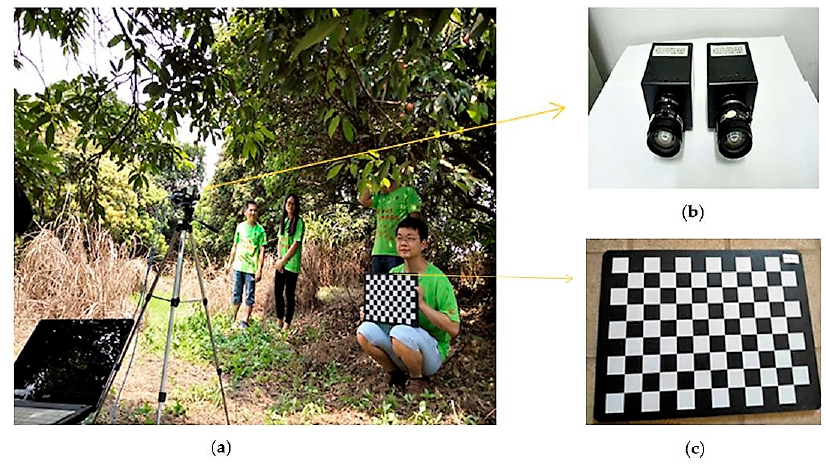
Figure 1. The proposed system figure: ( a ) Calibration of cameras; ( b ) Two CCD color cameras; ( c ) A calibration board.